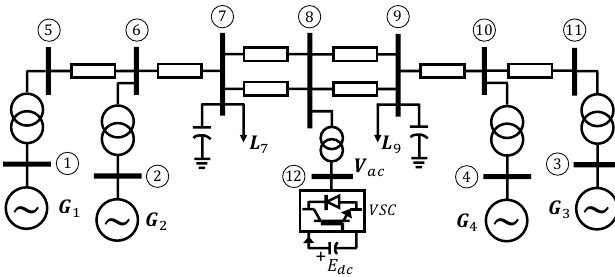
Figure 4. Four machine power system with StatCom at bus 8.